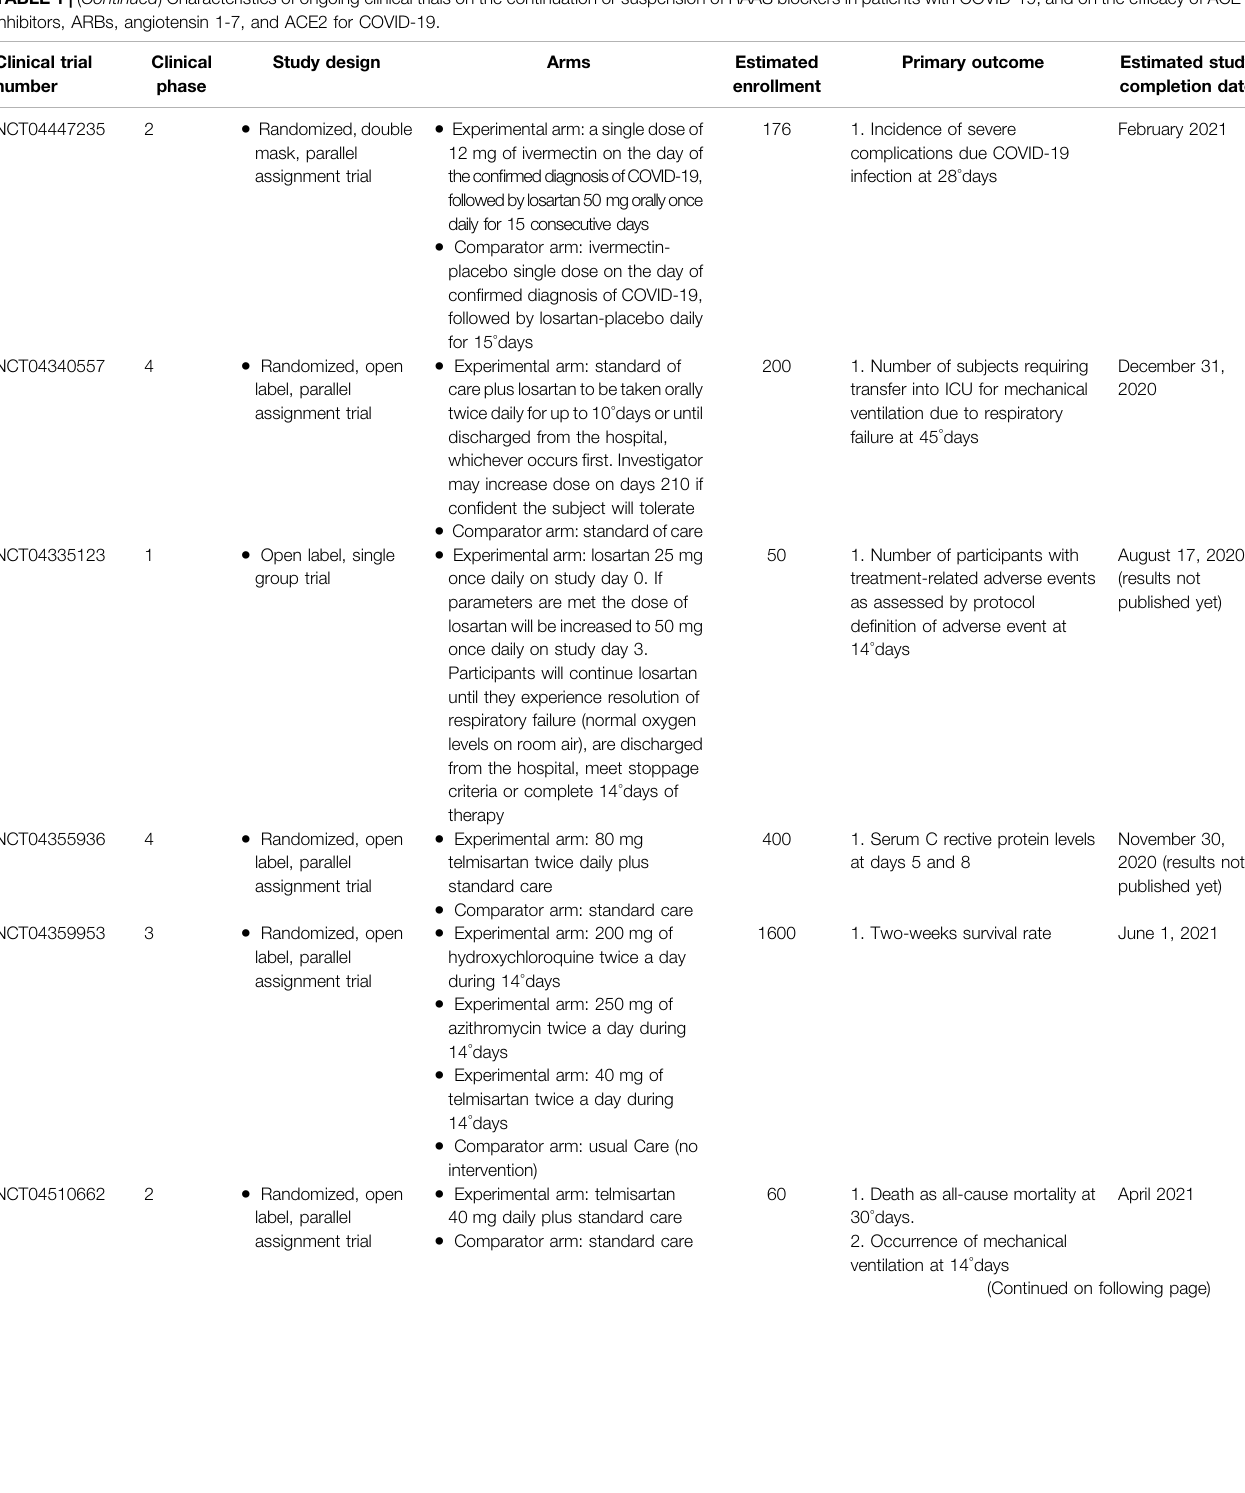
TABLE 1 | ( Continued ) Characteristics of ongoing clinical trials on the continuation or suspension of RAAS blockers in patients with COVID-19, and on the ef fi cacy of ACE inhibitors, ARBs, angiotensin 1-7, and ACE2 for